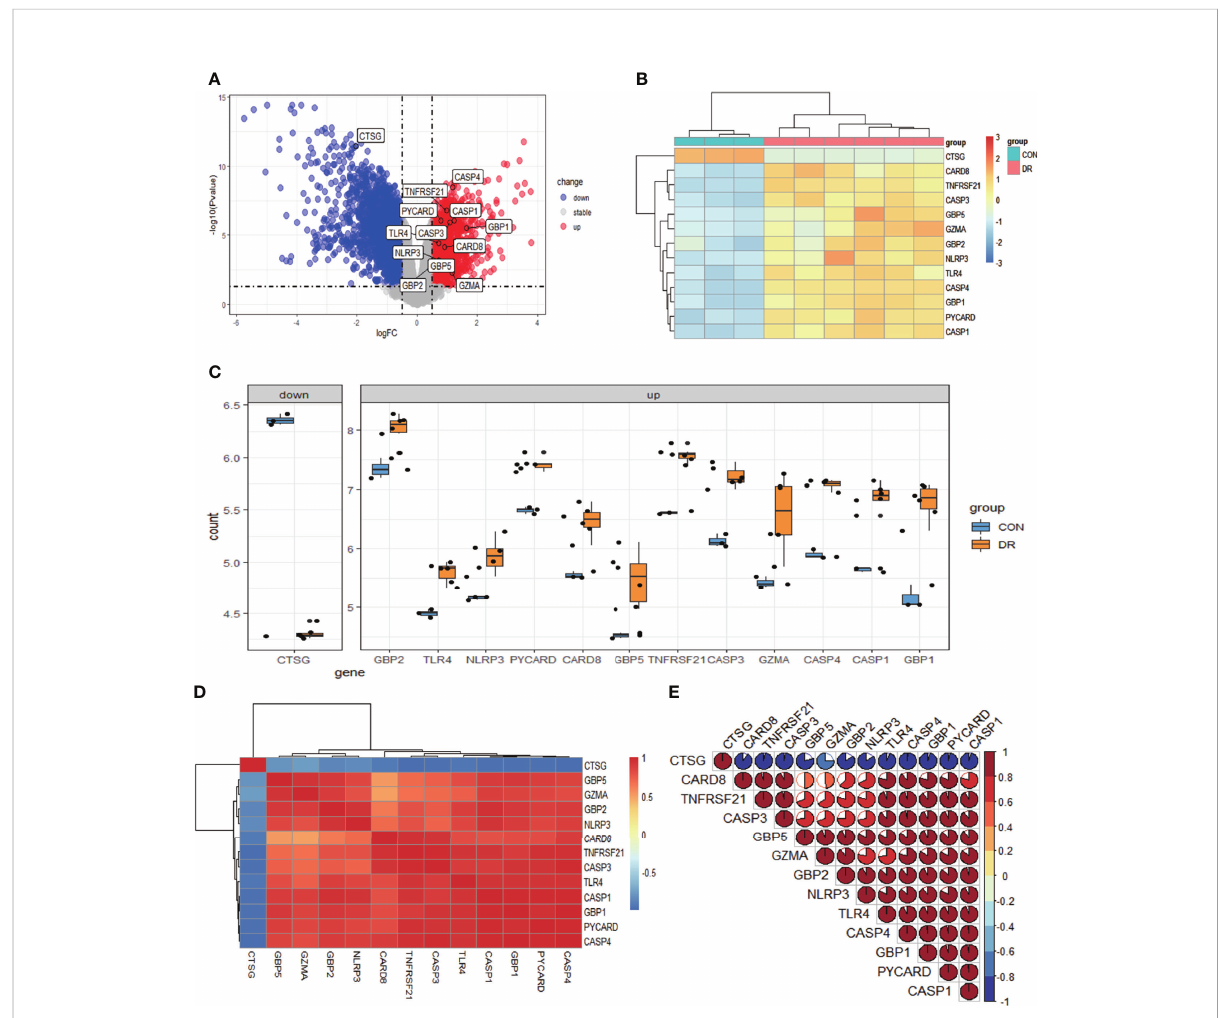
FIGURE 2 Differentially expressed PRGs in PDR and normal samples. (A) Volcano plot of 3,188 differentially expressed genes in the GSE60436 dataset. It contains 1,640 signi fi cantly upregulated genes, represented by red dots, and 1,548 signi fi cantly downregulated genes, represented by blue dots, whereas gray dots represent stably expressed genes. (B) Heatmap of 13 differentially expressed PRGs in the GSE60436 dataset. It contains one signi fi cantly downregulated gene and 12 signi fi cantly upregulated genes. The green bars represent control specimens from human retinas, denoted by “ CON ” , and the red bars represent specimens from PDR patients, denoted by “ DR ” . (C) Boxplot of 13 differentially expressed PRGs in FVM tissues of PRD patients and in RNA samples from human retinas. The blue bars represent control specimens from normal individuals, denoted by “ CON ” , and the yellow bars represent specimens from PDR patients, denoted by “ DR ” . Adjusted P -value <0.05 and |log 2 fold change| >0.5. (D, E) Correlation analysis of 13 differentially expressed PRGs. There was a strong correlation among the 12 upregulated genes. PRGs, pyroptosis-related genes; PDR, proliferative diabetic retinopathy; FVM, fi brovascular